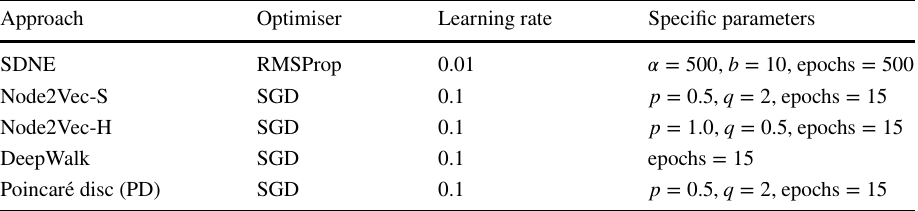
Table 2 Key hyper-parameter